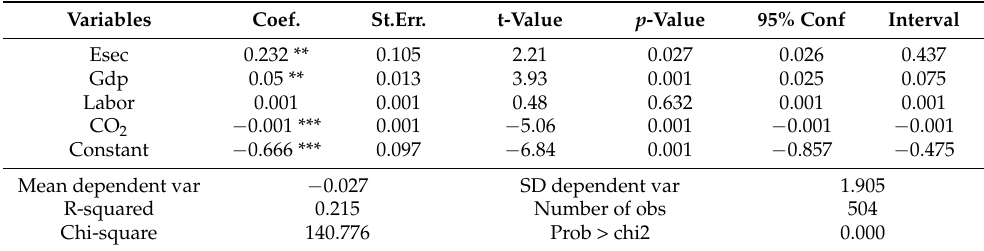
Table 5. Instrumental variables (2SLS)